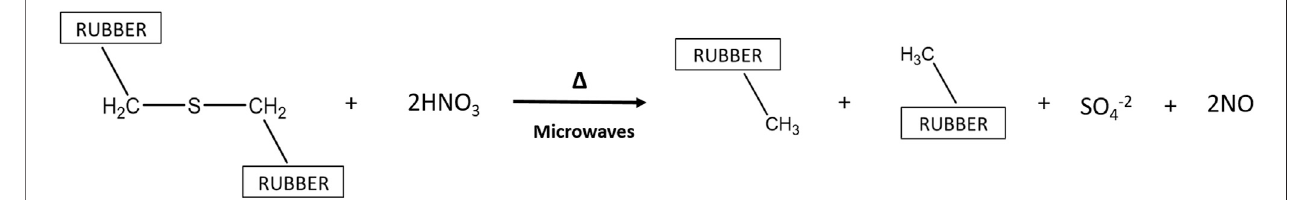
FIGURE 4 | Proposed mechanism for rubber desulfurization using HNO 3 and